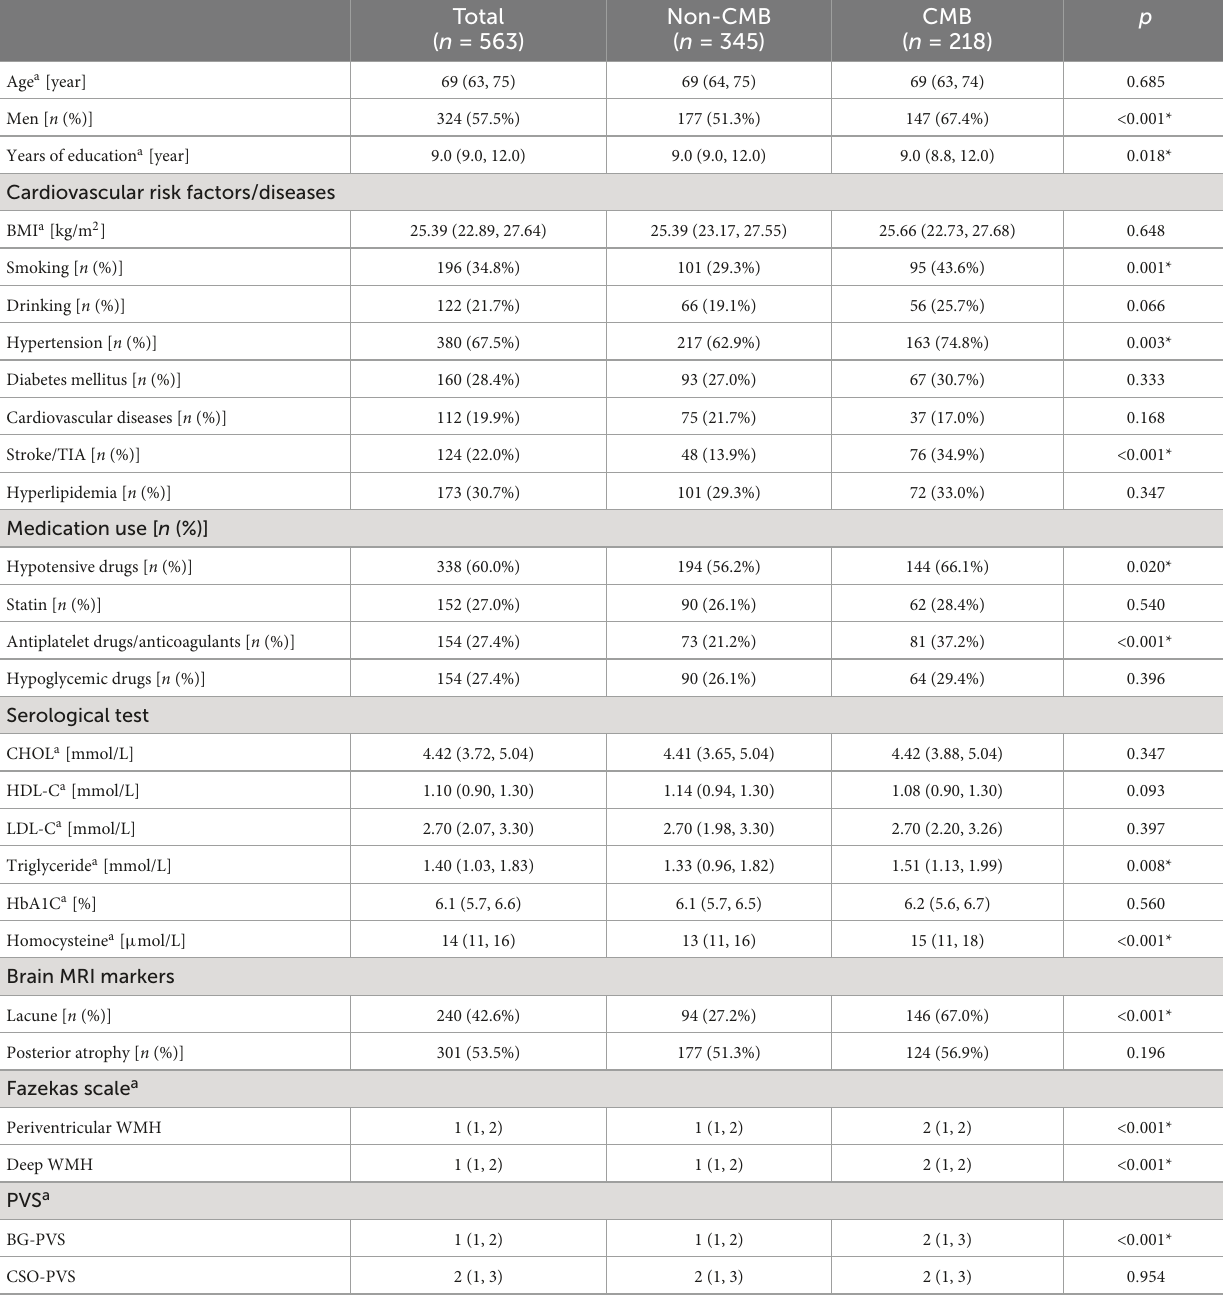
TABLE 1 Demographic data and clinical